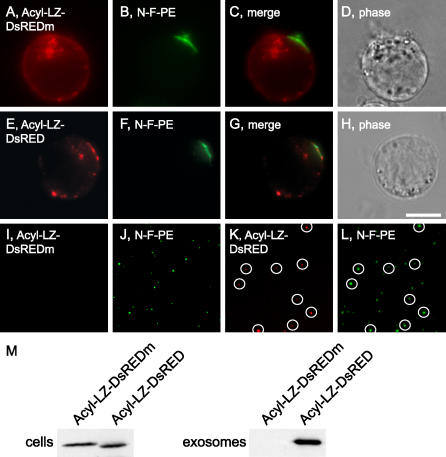
Vesicular Secretion of a Synthetic Exosomal Cargo(A–H) Fluorescence micrographs of N-F-PE–labeled Jurkat T cells expressing (A–D) Acyl-LZ-DsREDmonomer or (E–H) Acyl-LZ-DsRED.(I–L) Fluorescence micrographs of exosomes secreted by N-F-PE–labeled Jurkat T cells expressing (I and J) Acyl-LZ-DsREDmonomer or (K and L) Acyl-LZ-DsRED. White circles mark exosomes that contain both N-F-PE and Acyl-LZ-DsRED. Bar indicates 10 μm.(M) Anti-DsRED immunoblot of exosome and cell lysates of Jurkat T cells expressing (left lanes) Acyl-LZ-DsREDmonomer or (right lanes) Acyl-LZ-DsRED (equal ratios of exosome lysate:cell lysate).